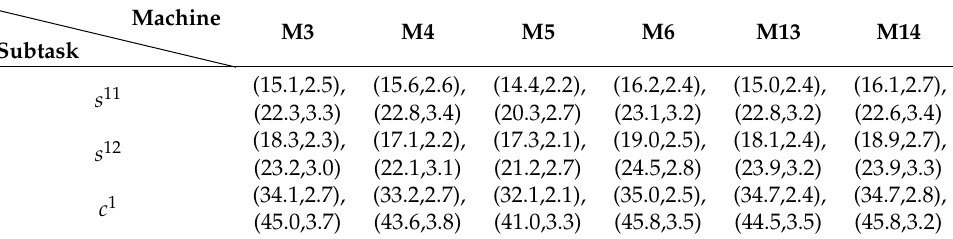
Table 3. Time distributions of changeover subtasks (Unit: Min).